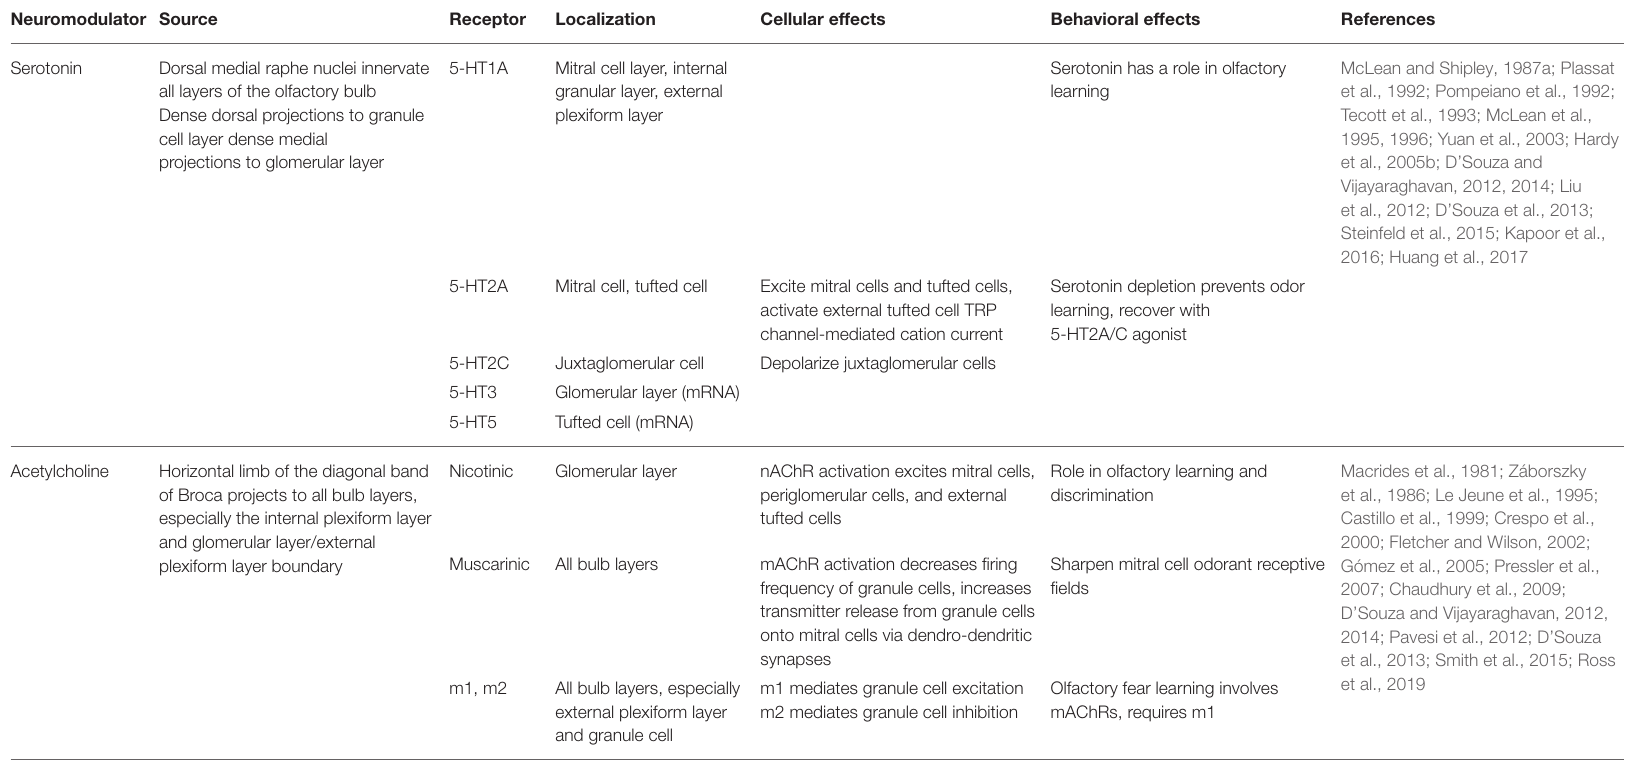
5-HT, serotonin; TRP, transient receptor potential; AChR, acetylcholine